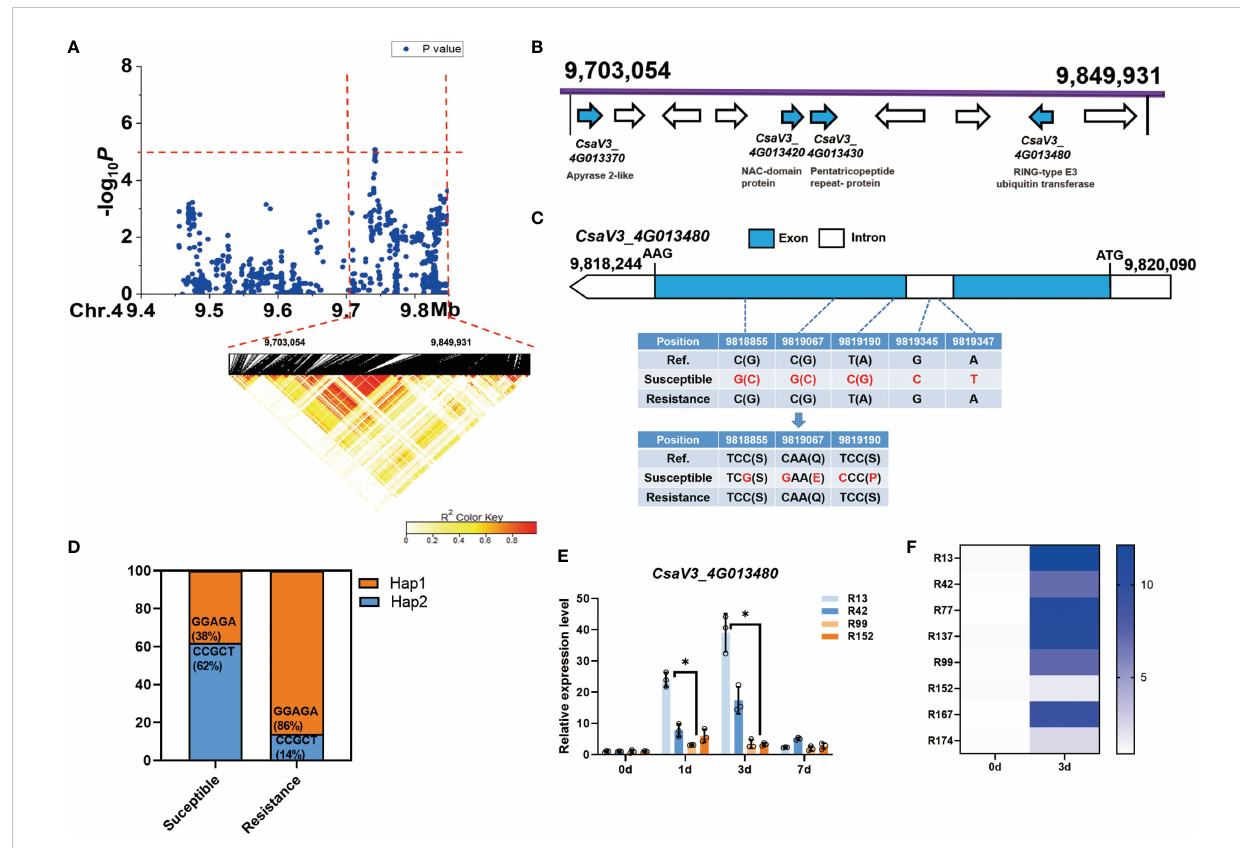
FIGURE 6 Identi fi cation of cucumber low-temperature germination trait-associated gene CsaV3_4G013480 . (A) Local Manhattan plot (top) and LD heatmap (bottom) surrounding the peak on chromosome 4. The dashed line indicates the signi fi cance threshold ( P < 10 − 6 ). Dashed lines indicate the candidate region (~ 146.8 kb) for the peak. (B) Ten functionally annotated genes were predicted in the gLTG4.1 candidate region. The arrows represent the direction of the genes. The genes shown as blue arrows are related to abiotic stress. Gene annotation is listed below. (C) Gene structure of CsaV3_4G013480 . Blue and white rectangles indicate exons and introns, respectively. (D) Orange represents the proportion of accessions that are Hap1 (GGAGA) while blue represents the proportion that are Hap2 (CCGCT) among the susceptible and resistant lines. (E) The expression level of CsaV3_4G013480 in the LT-sensitive lines ( ‘ R13 ’ , ‘ R42 ’ ) and LT-resistant lines ( ‘ R99 ’ , ‘ R152 ’ ) after LT treatment (0, 1, 3 and 7 d), was tested through qRT – PCR. Actin was used an internal control. Data are represented as average values with the SD of three independent biological replicates. (F) The heatmap indicates the relative expression level of CsaV3_4G013480 in LT-sensitive lines ( ‘ R13 ’ , ‘ R42 ’ , ‘ R77 ’ , ‘ R137 ’ ) and LT-resistant lines ( ‘ R99 ’ , ‘ R152 ’ , ‘ R167 ’ , ‘ R174 ’ ) after LT treatment (0 d and 3 d), tested through qRT – PCR. Actin was used an internal control. *Signi fi cant difference ( P <0.05